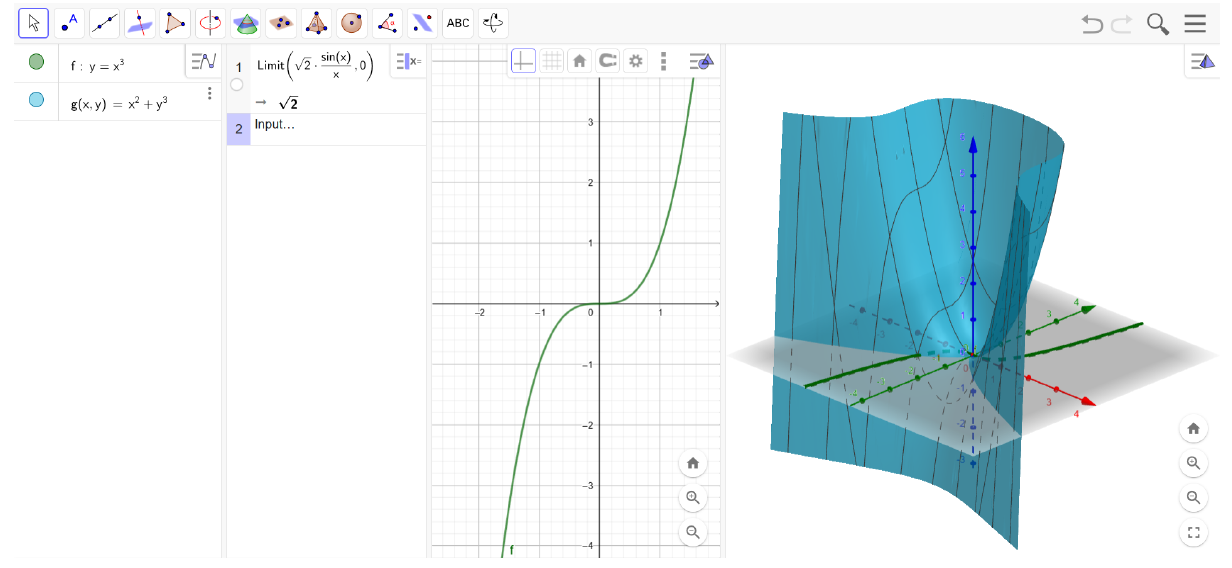
Figure 1. GeoGebra Classic